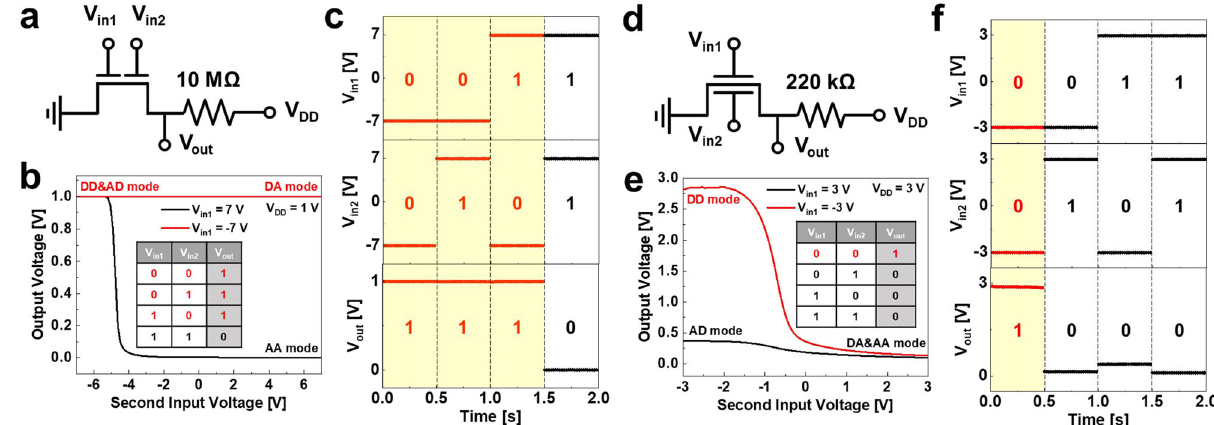
Fig. 4 Demonstration of NAND and NOR logic gates. a , d Inverter circuit diagram consisting of the external resistor with the AND-FET ( a ) and the OR-FET ( d ). b , e The VTC curves are shown as a function of V in2 with the fi xed V in1 in the AND-FET ( b ) and the OR-FET ( e ). The inset tables show the truth tables of the NAND and NOR logic gates. c , f The time-domain operation of our NAND ( c ) and NOR ( f ) logic